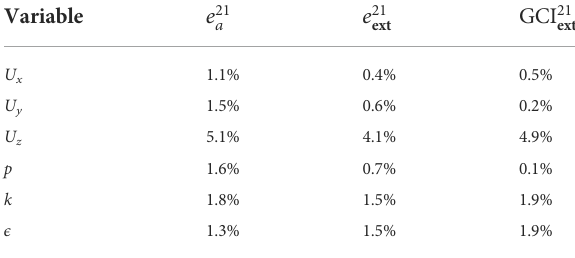
TABLE 2 Grid convergence study, median values from 32